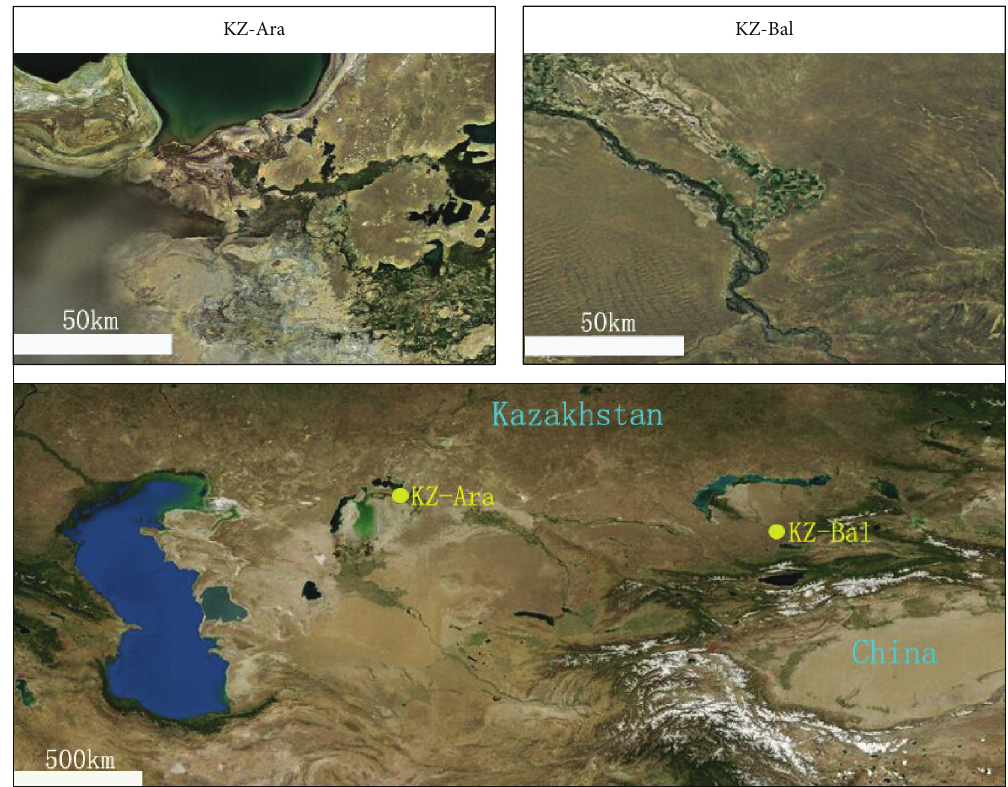
Figure 1: Study area and location of the two eddy covariance (EC) sites in